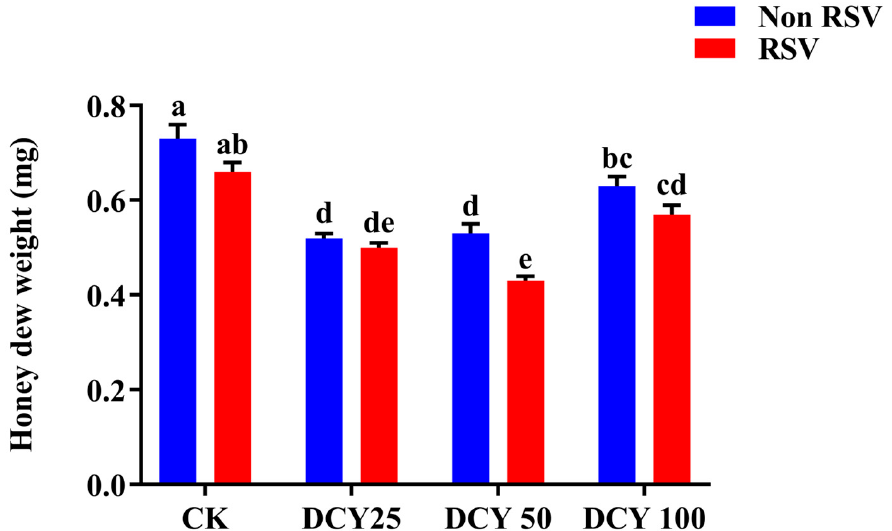
Figure 6. Honeydew weight of different populations of female SBPH on DCY-treated rice. Significant